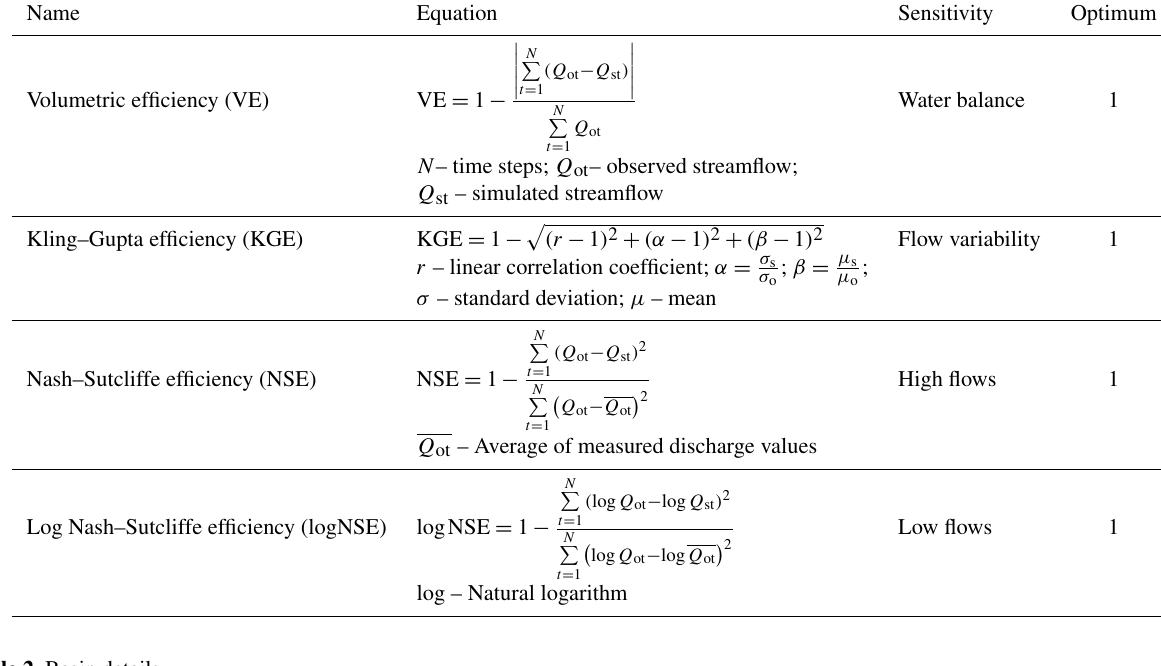
Table 1. Absolute performance measures used in the current study.